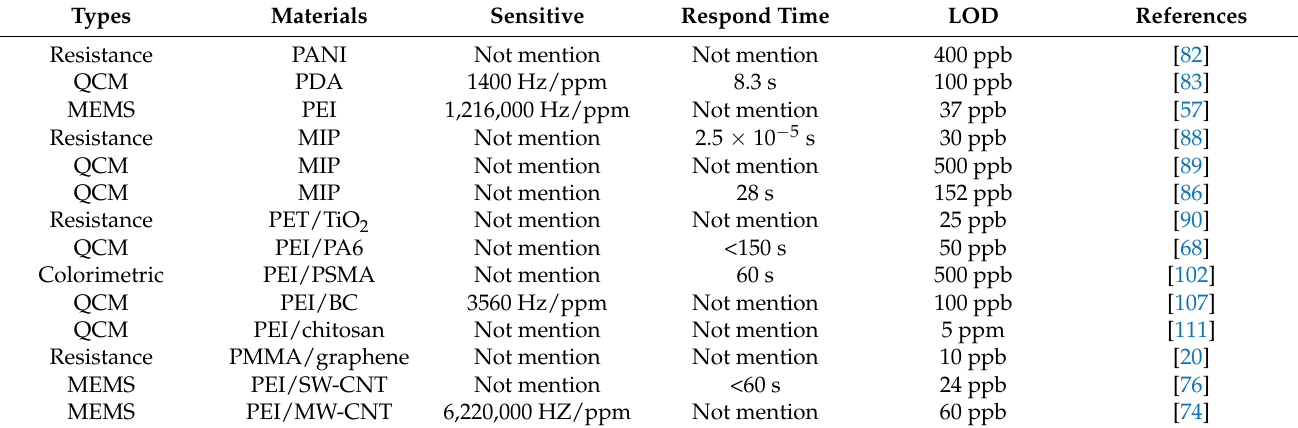
Table 1. Formaldehyde sensor based on single polymer and polymer